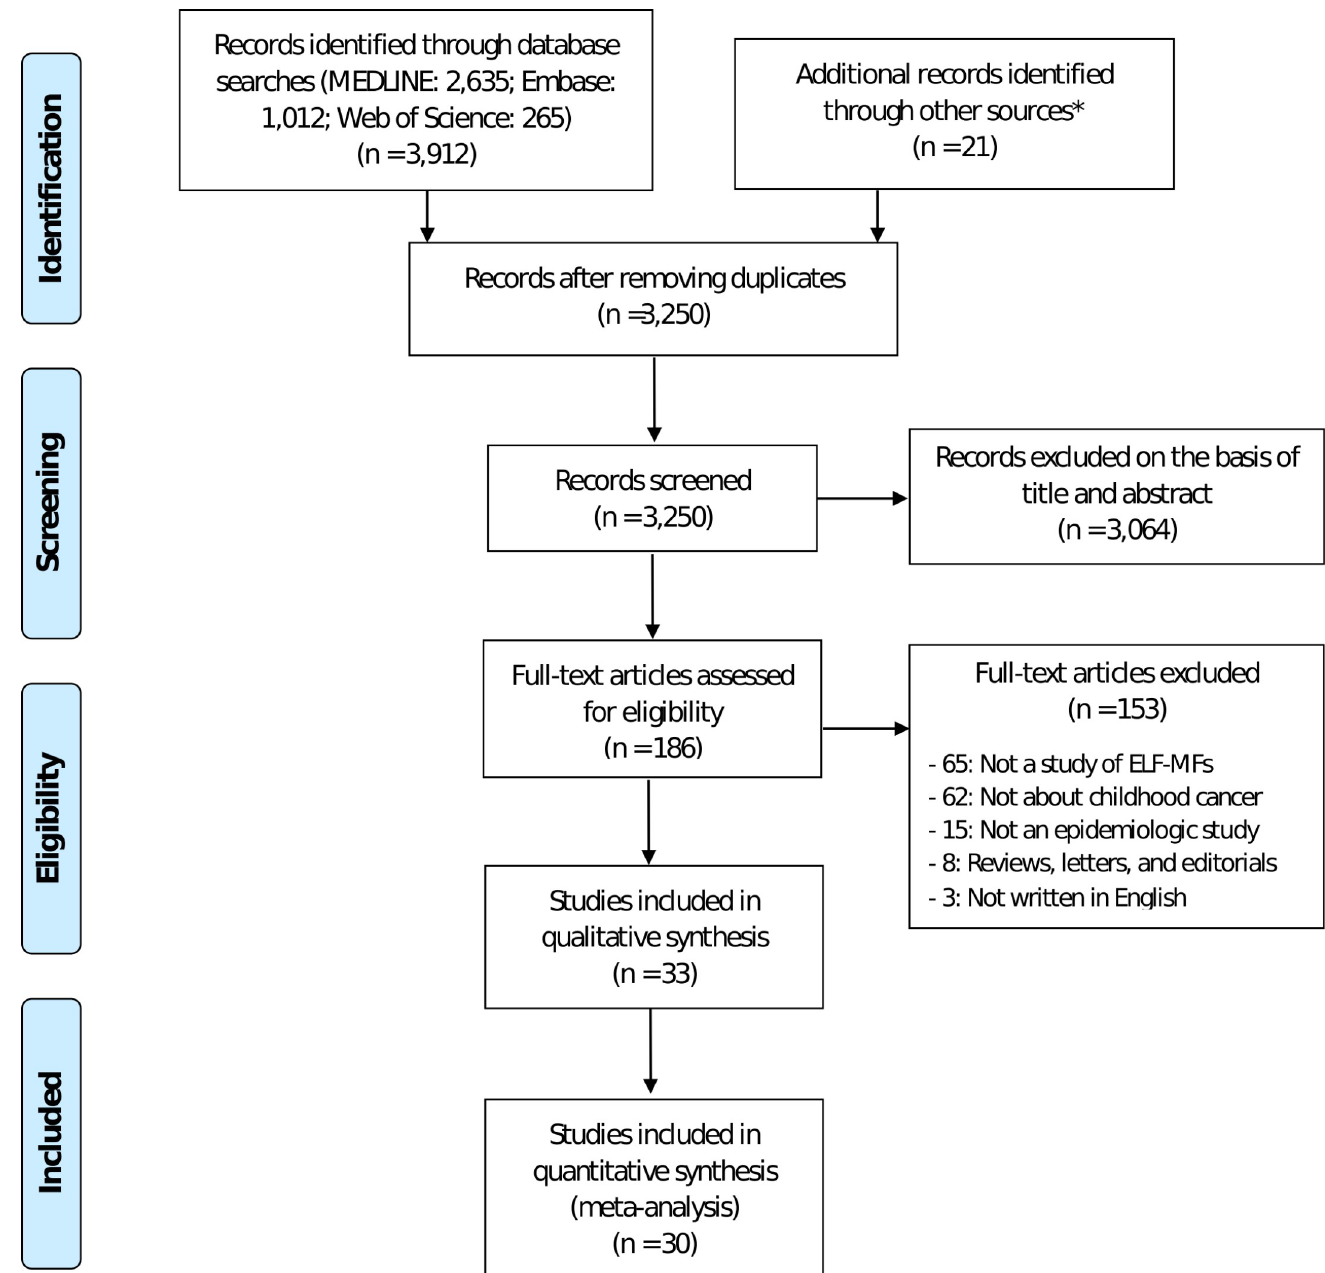
Fig 1. The flow chart of the search for eligible studies. PRISMA flow diagram with the process of identification, screening, eligibility, and included studies in systematic review and meta-analysis. n number of studies. � The additional studies were identified from the EMF research databases (www.emf-portal.org) and the references list of the retrieved